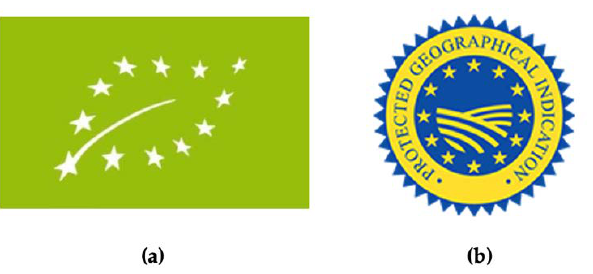
Figure 1. Third-party certified labels used in the research. ( a ) EU organic label (environmental sus- tainability). Regulation EU 2018/848 of the European Parliament and of the Council of 30 May 2018; ( b ) PGI label (socioeconomic sustainability). Regulation EU 1151/2012 of the European Parliament and of the Council of 21 November 2012.